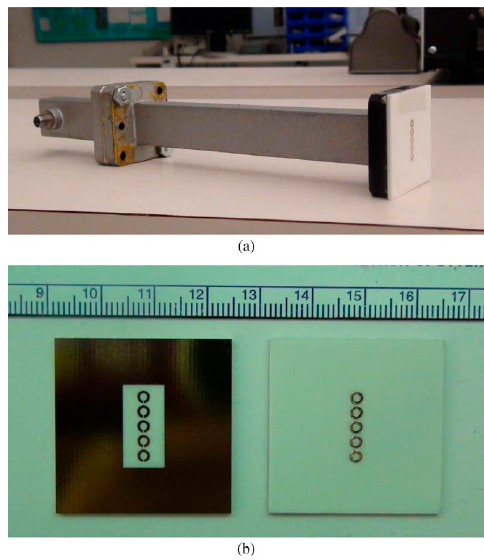
Figure 23. ( a ) Photograph of the real probe; ( b ) photographs of the top and bottom views of the PCB with the SRR array (from [40]; Copyright © IEEE 2014; reproduced with permission).